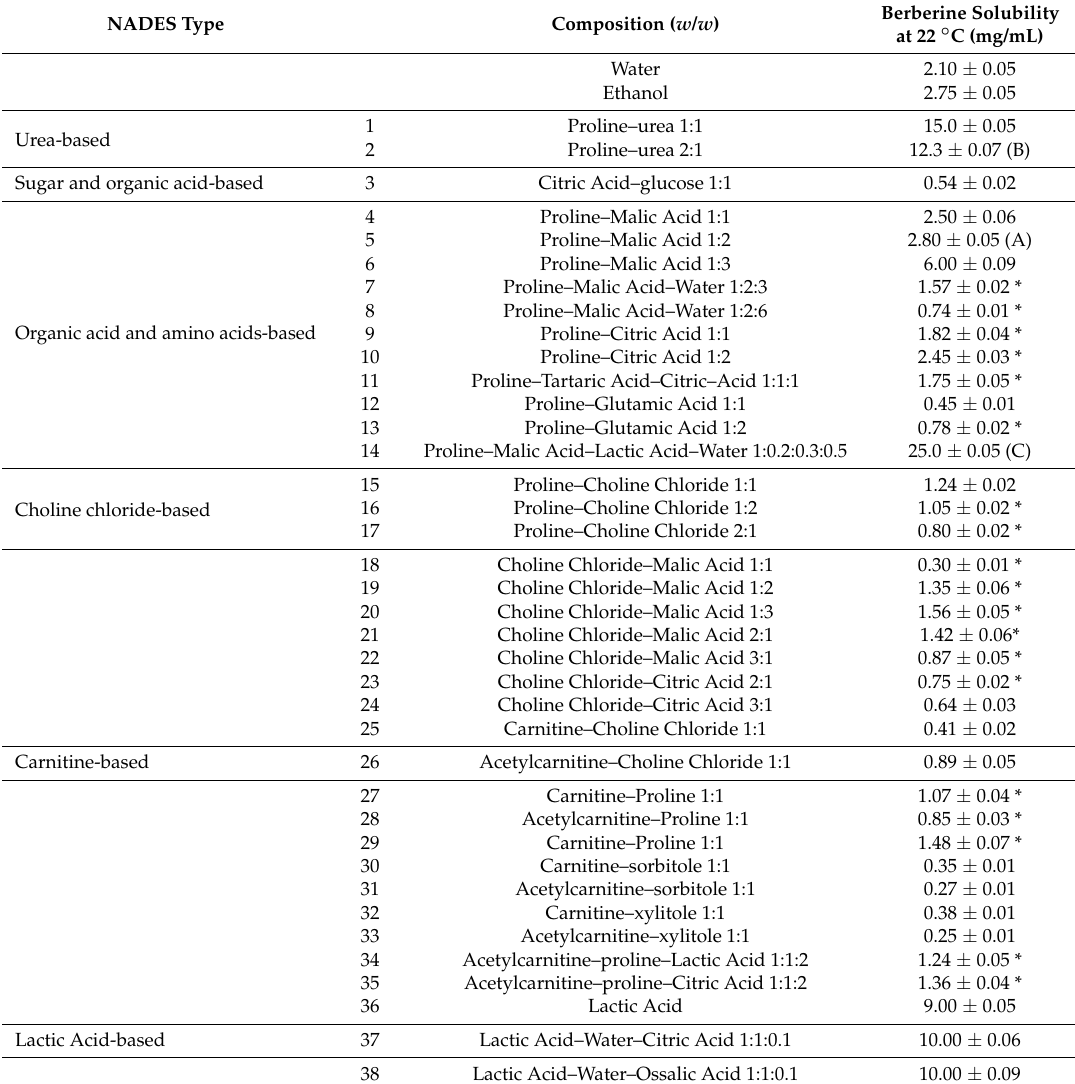
Table 1. Solubility of berberine (mean ± SD; n = 3) in NADES and reference solvents. The solubility in all solvents were significantly different from solubility in water ( p -values <